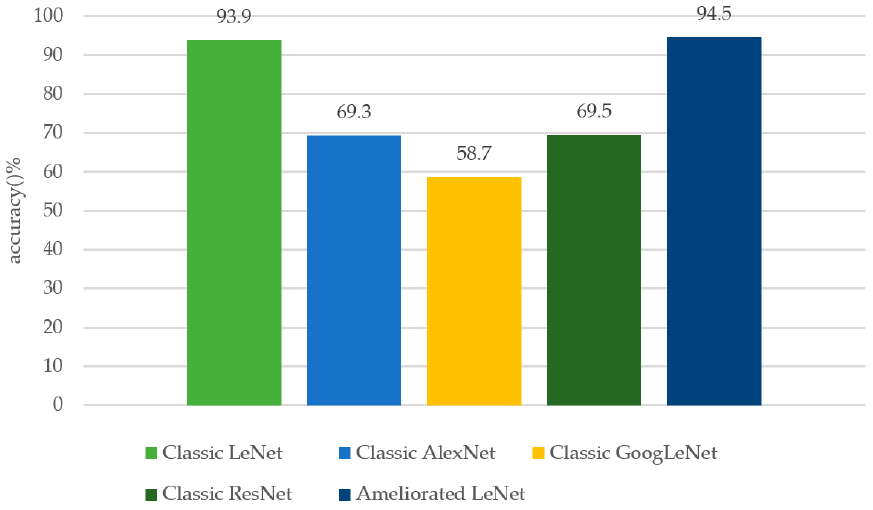
Figure 18. The test accuracy of every network on the test set at epoch five.